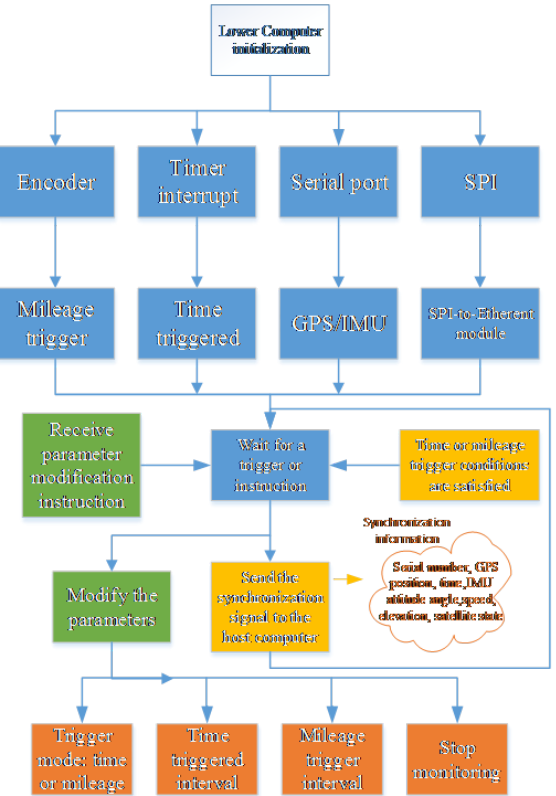
Figure 5. The flow chart of the lower computer